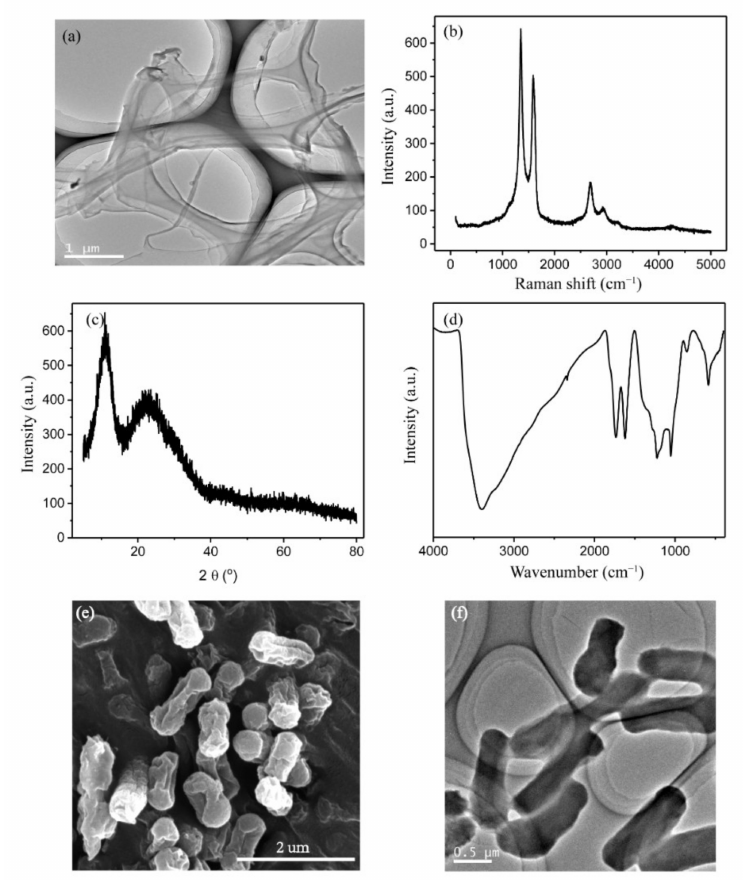
Figure 1. The TEM ( a ), Raman spectra ( b ), XRD spectra ( c ), and FT-IR spectra ( d ) of GORs, and SEM ( e ) and TEM ( f ) of E. coli